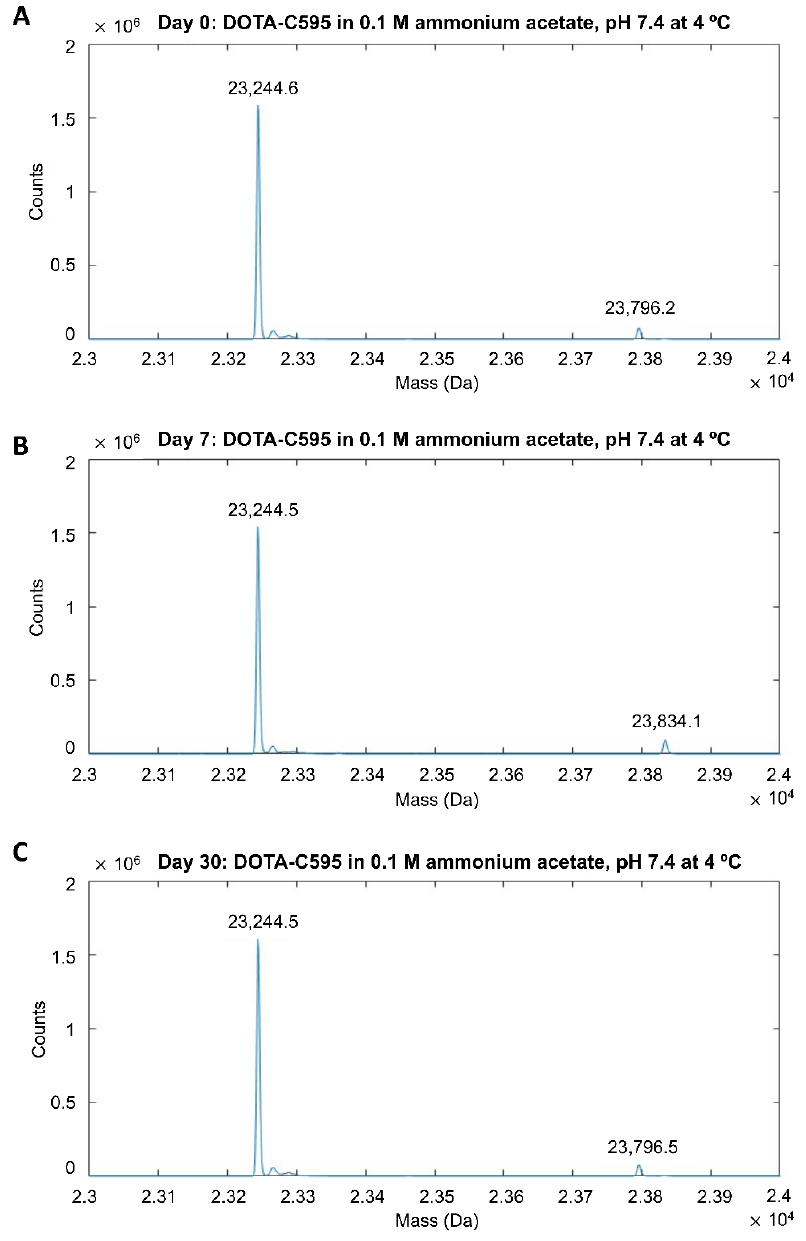
Figure 3. Mass spectra of light chain p-SCN-Bn-DOTA-C595 conjugate stored in 0.1 M ammonium acetate (pH 7.4) at 4 °C at ( A ) day 0, ( B ) day 7 and ( C ) day 30.